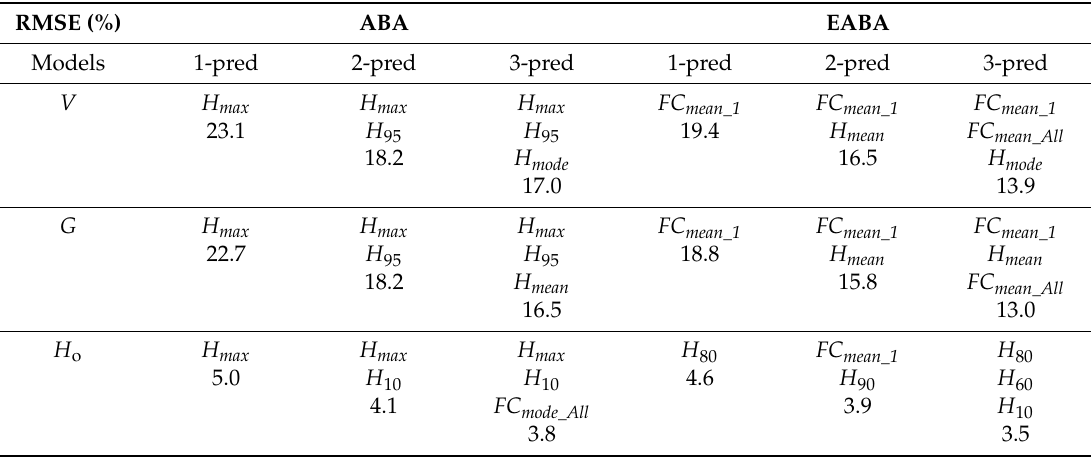
Table 3. Selection of predictors and computed RMSE (expressed as the percentage value over the mean value of the ground measurements) for the one-, two-, and three-parameter models fitted with OLS regression. The results are presented for the standard ABA approach (left) and the improved EABA method (right).